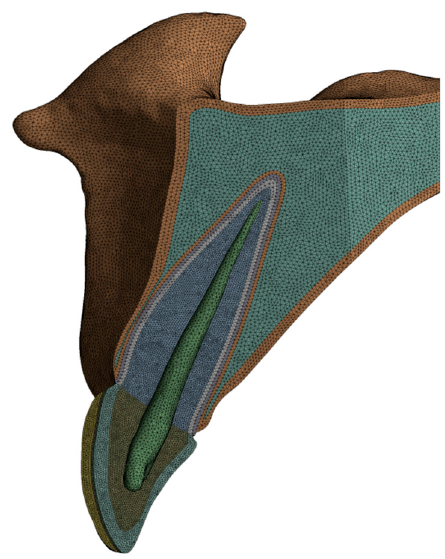
Figure 3. Sagittal section view of the finite element mesh of the maxillary central incisor with veneer restoration.